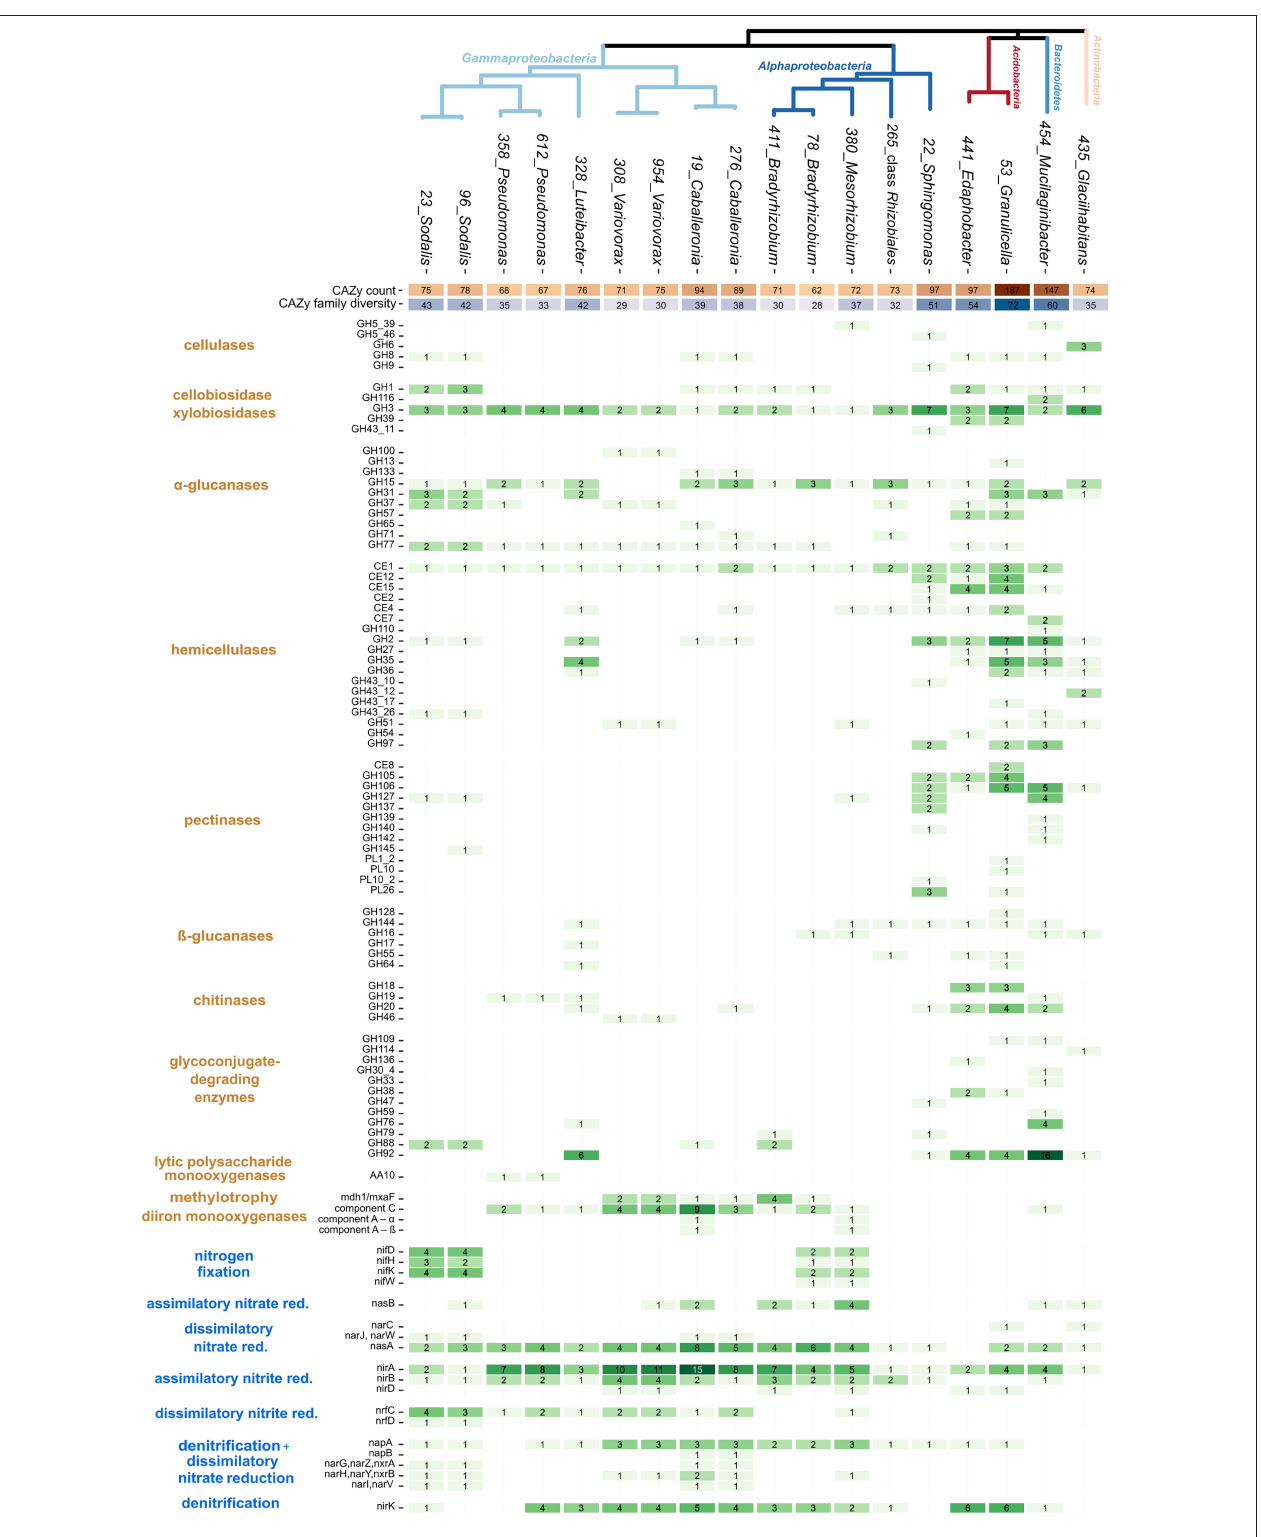
FIGURE 2 | Genomic traits of dominant bacteria associated with decomposing deadwood. Heatmap shows CAZy counts, counts of genes for low-molecular-mass compounds utilization, and counts of N cycle-related genes together with putative functional annotation of each gene. The total number of CAZy genes and counts of CAZy families (CAZy diversity) per genome are depicted as heatmaps in the upper rows. A phylogenetic tree based on single-copy marker genes shows the phylogenetic relatedness of individual strains.